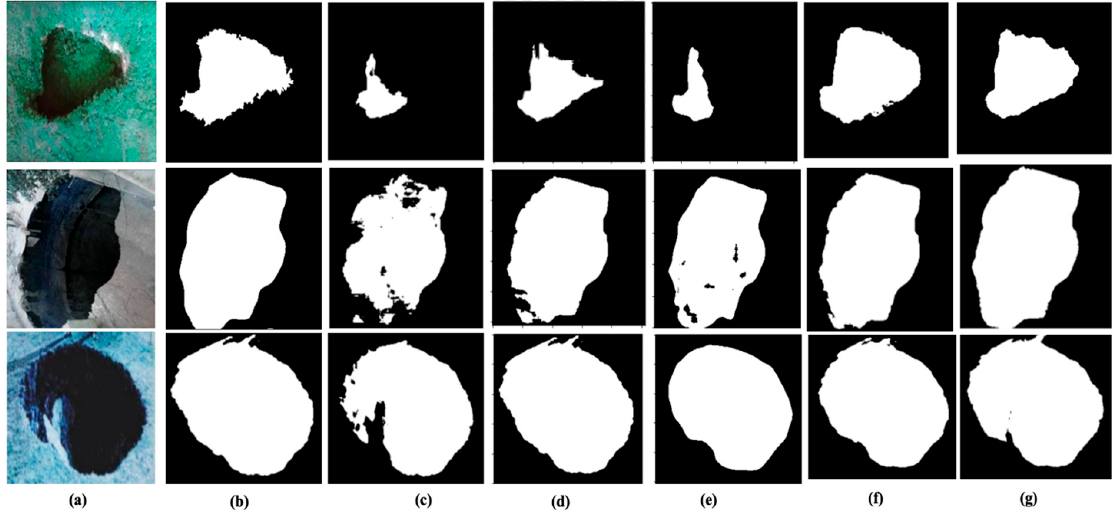
Figure 10. Visual comparisons among the segmentation models on the sinkhole dataset: ( a ) the original images; ( b ) the ground truth; ( c ) U-Net; ( d ) Depth-Separable U-Net; ( e ) Attention U-Net; ( f ) Inception U-Net; and ( g ) our model’s results.